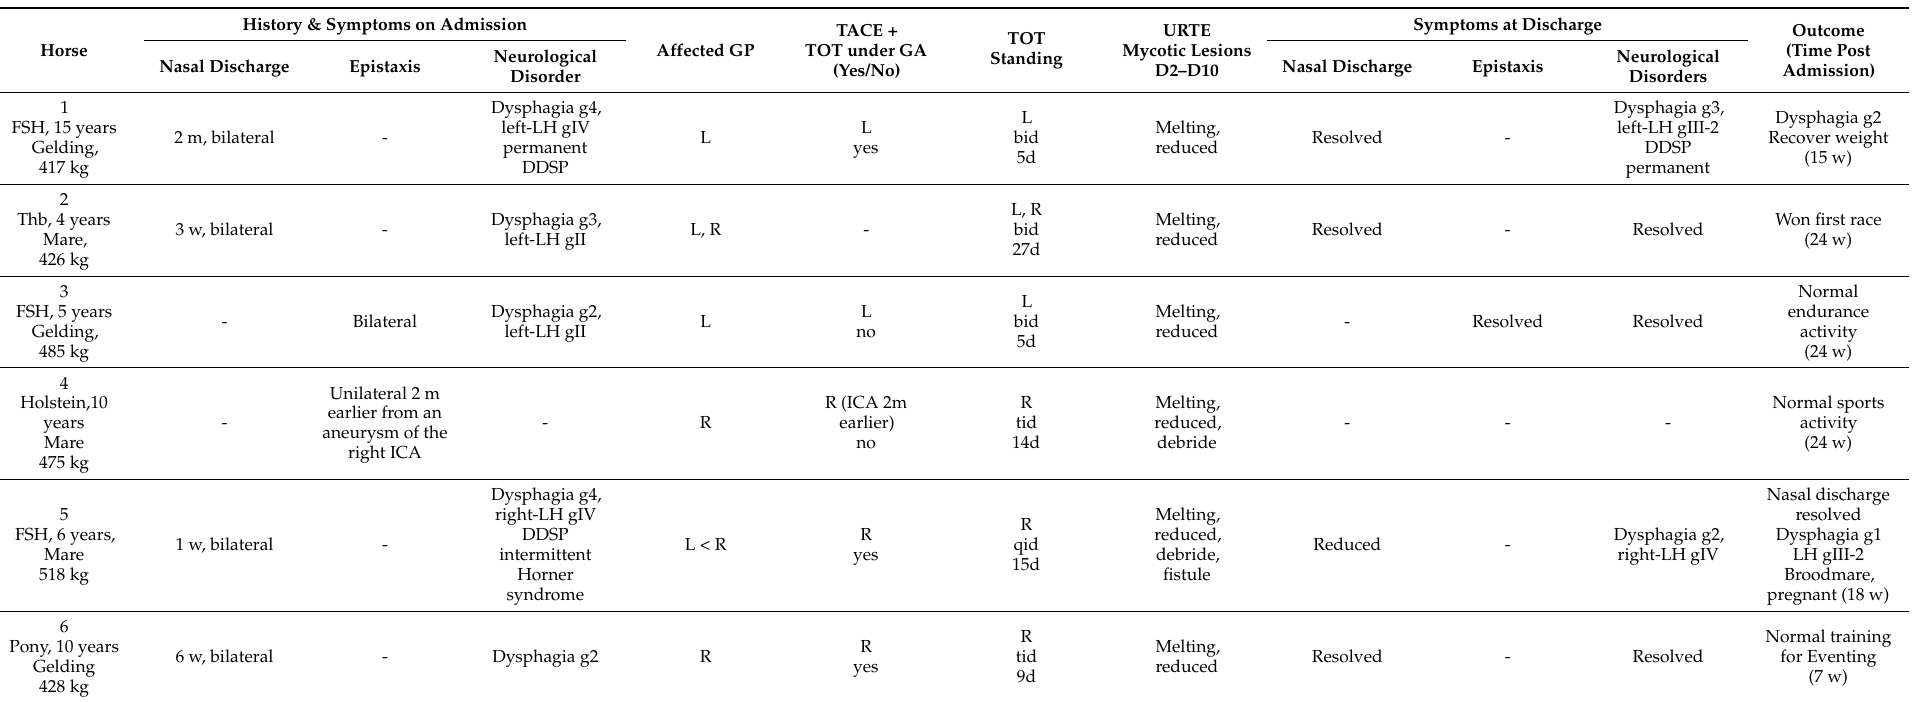
Table 1. Clinical findings, treatment, and outcome for horses in the phase-2 clinical